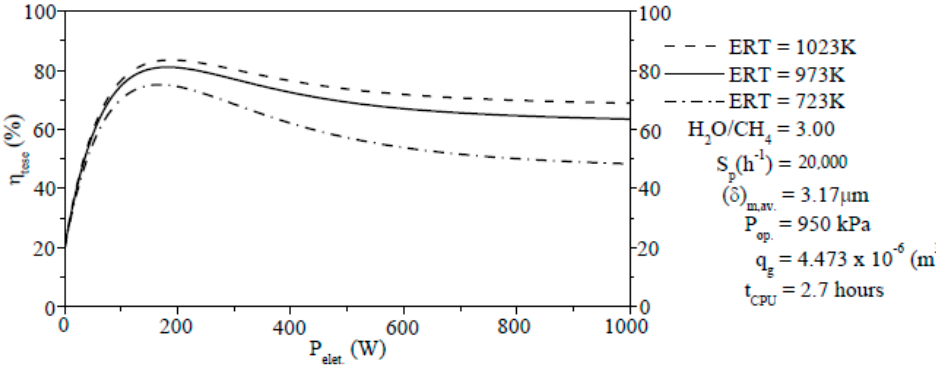
Figure 10. Effect of the ERT on the η tese of the SRM method in PBMR on Ni/Mg/ γ -A ℓ 2 O 3 with 6% Ni loading.